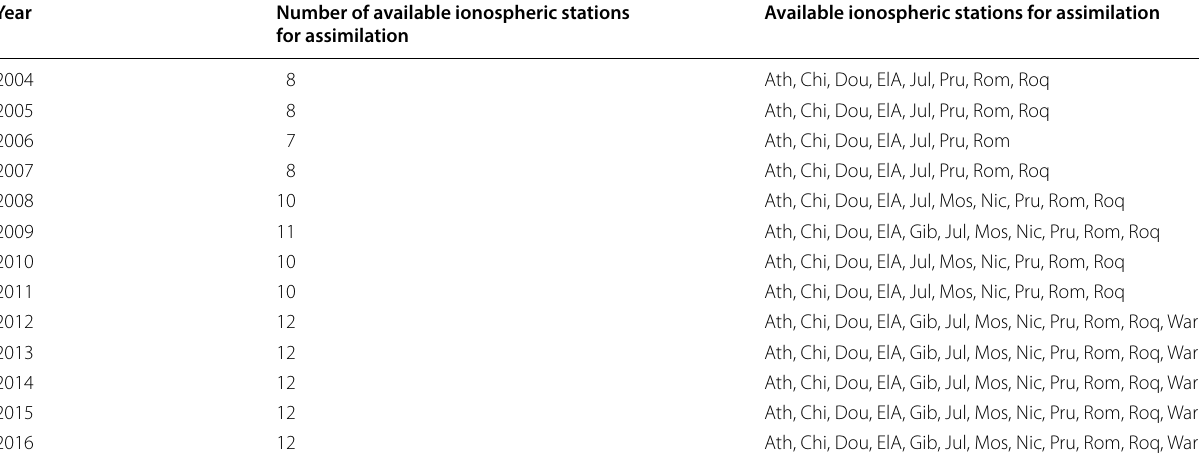
Ionospheric stations available for data assimilation for each year, from 2004 to 2016